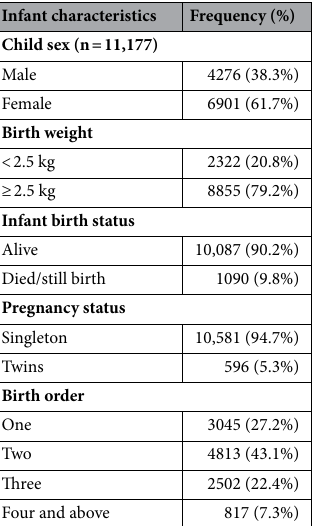
Table 3. Characteristics of newborn babies born at Felege-Hiwot Comprehensive Specialized Referral hospital, from Sept. 2009 to Aug. 2014, Bahir Dar, Ethiopia.